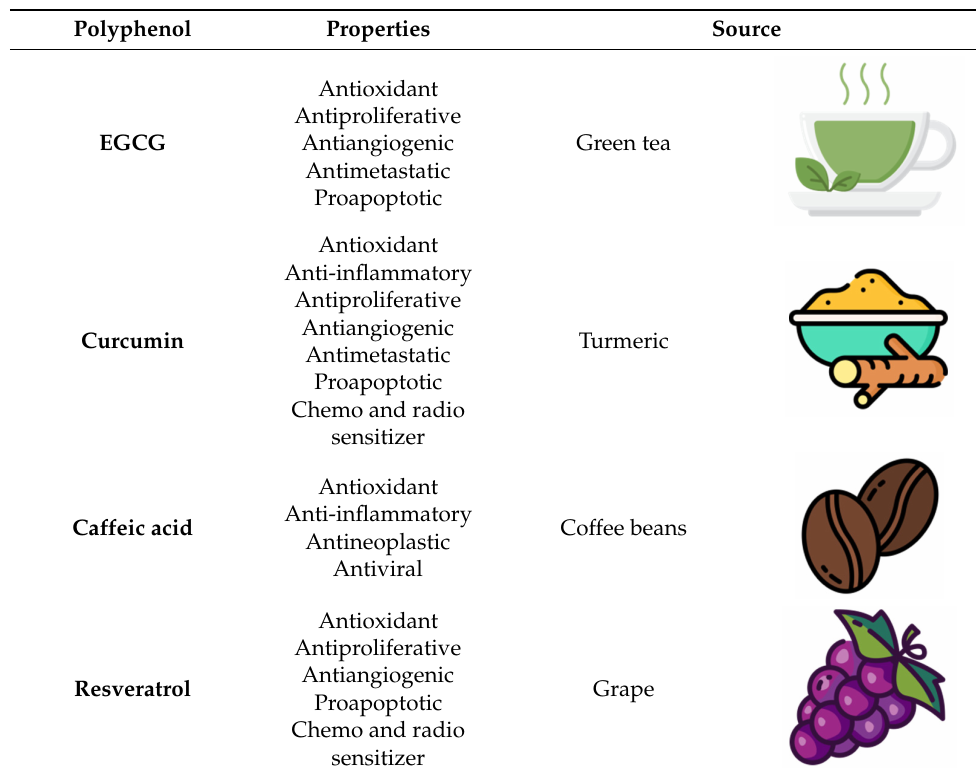
Table 1. Polyphenols: Properties and sources